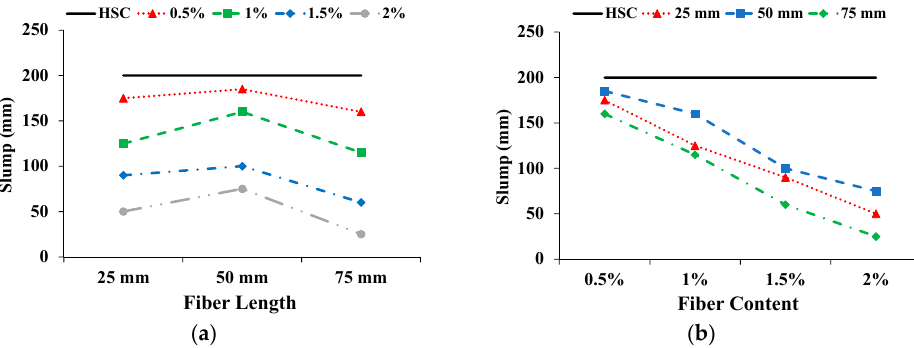
Figure 2. Influence on slump: ( a ) Fiber length; ( b ) Fiber content .